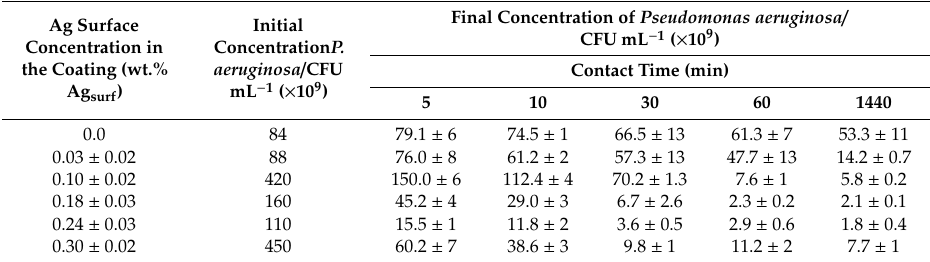
Table 3. Final bacterial ( P. aeruginosa ) concentrations after different contact times between the fermentation broth and Zn/AgP surfaces with different AgP concentrations in the coatings and 24 h de incubation.